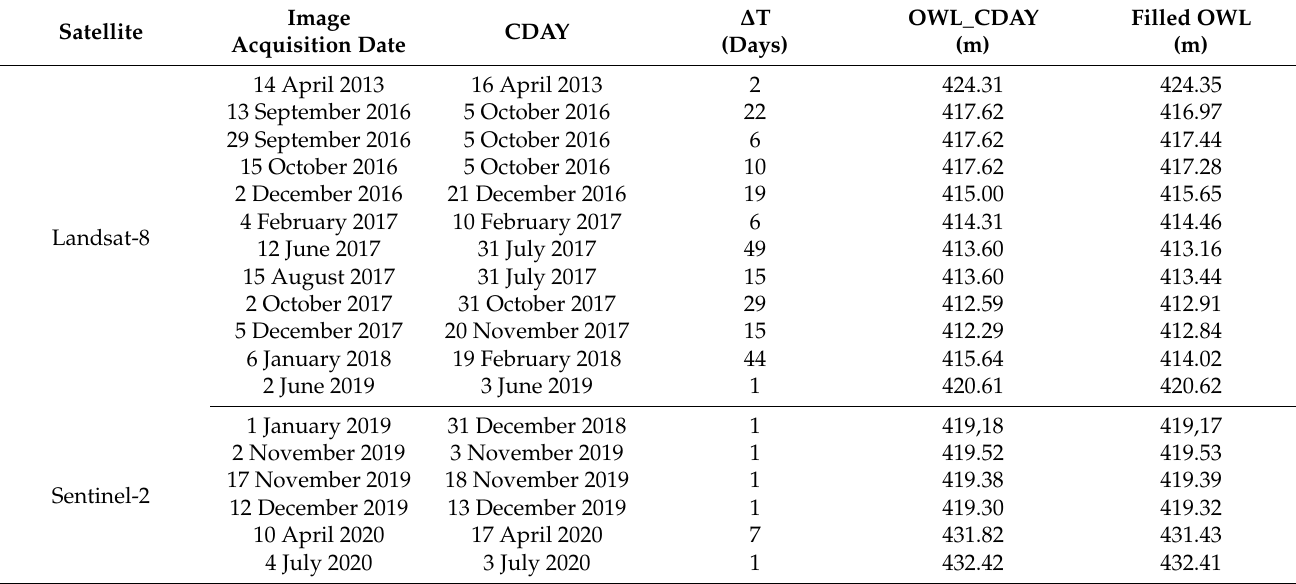
Table 1. Filled gaps in observed water level